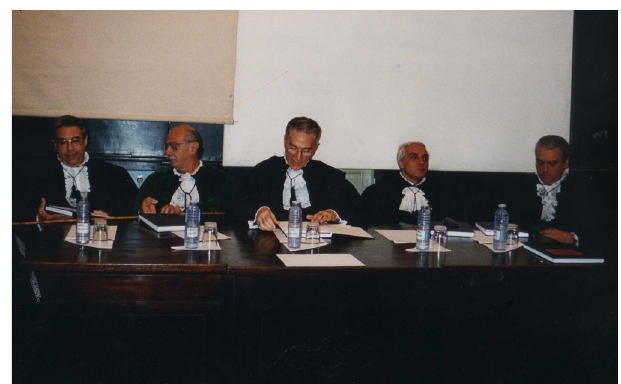
Fig. 2 – Examination board at USP Medical School. From left to right, professors: Domingo Braile, Adib Jatene, Geraldo Verginelli, Noedir Stolf, and Enio Buffolo.